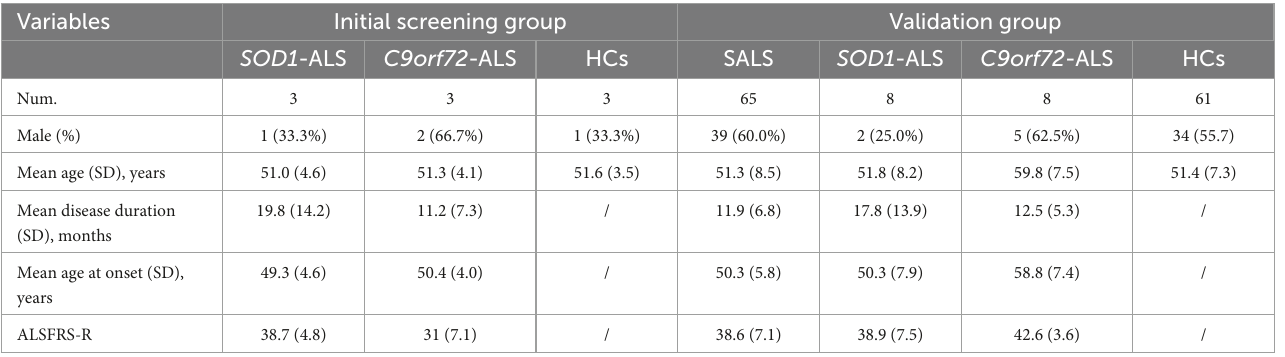
TABLE 1 The demographic characteristics and clinical information of participants in this study. Variables Initial screening group